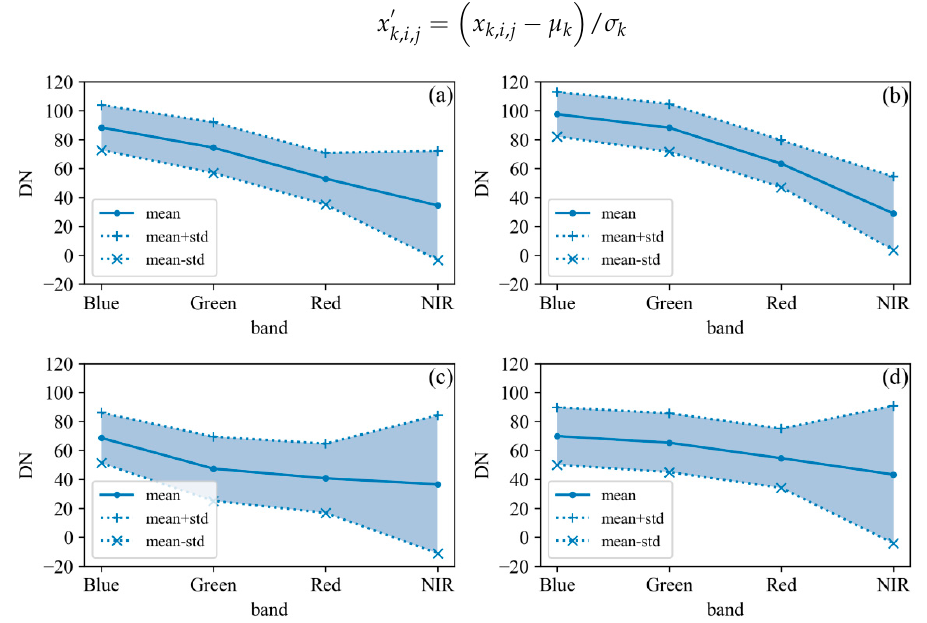
Figure 6. Spectral features of sample from different time. ( a ) Sample from November 2013. ( b ) Sample from November 2017. ( c ) Sample from April 2020. ( d ) Sample from August 2020.